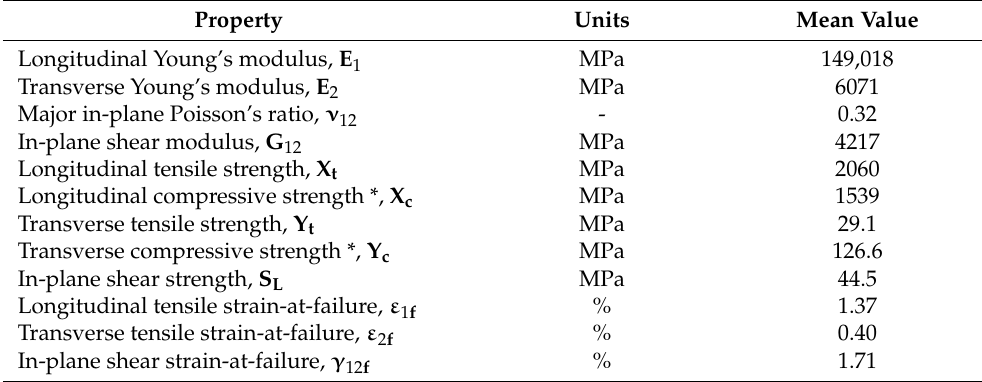
Table 2. Mechanical properties of the unidirectional NCF